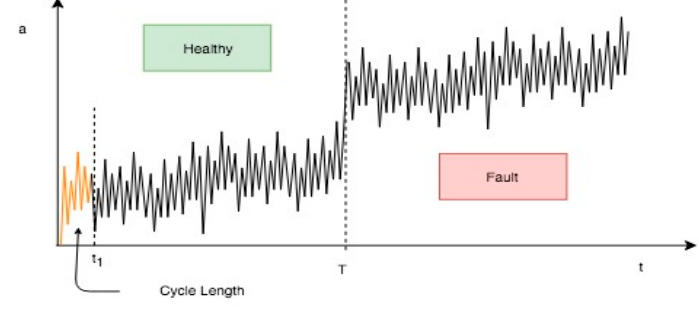
Figure 4. Example of vibration Signal.